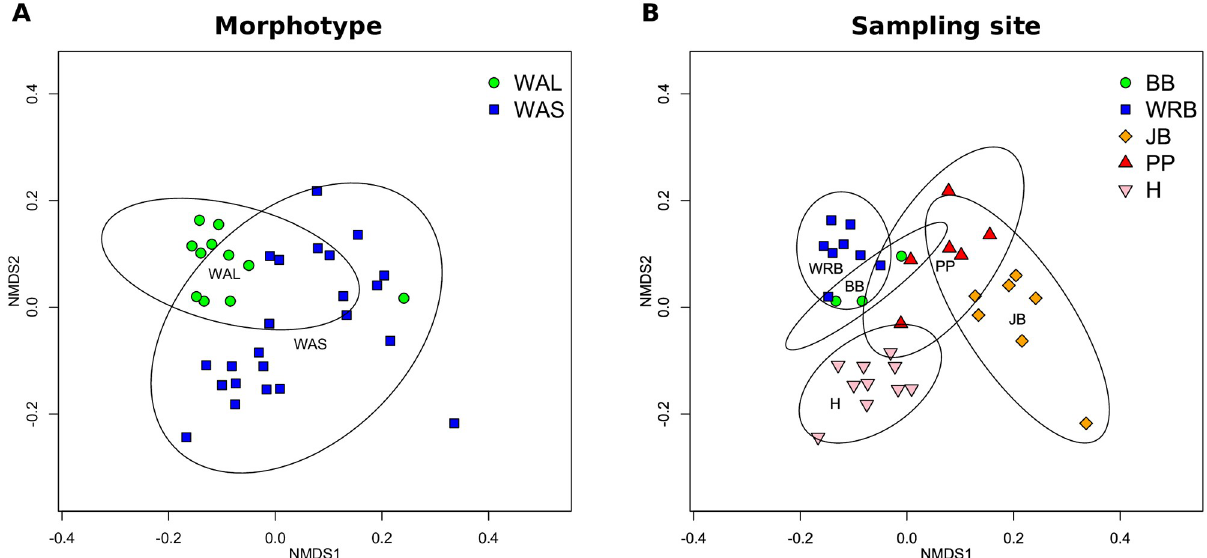
Fig 5. NMDS plots showing the community composition of 26 Amphisorus -associated bacteria based on Bray-Curtis distance. A) Differences in bacterial community composition between WAS and WAL morphotype. B) Differences in bacterial community composition between sampling